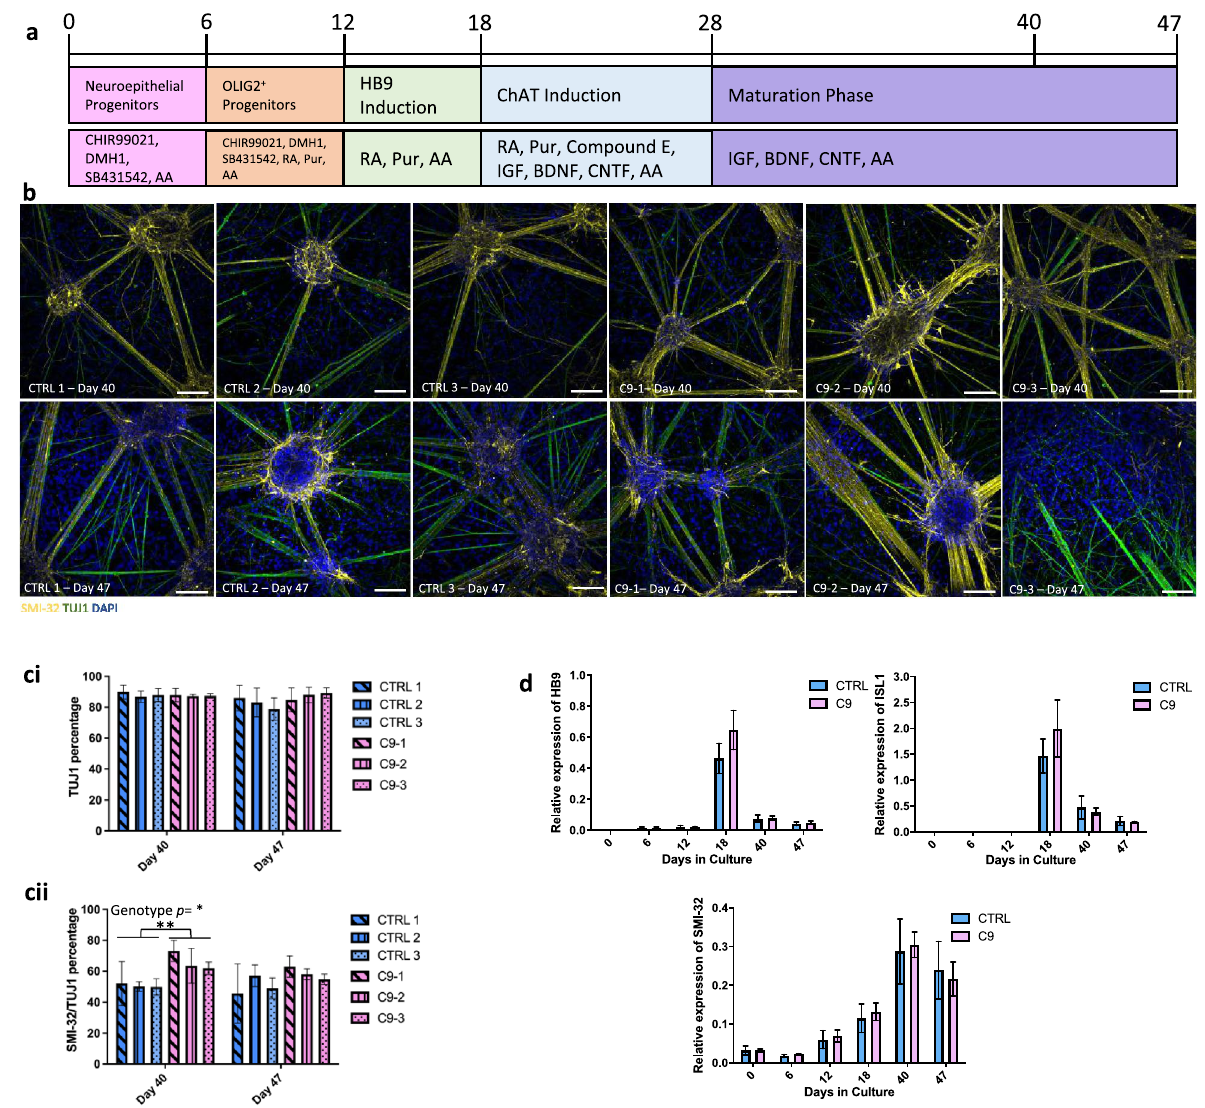
Figure 1. Characterization of C9ORF72 MNs and CTRL MNs. ( a ) Diagram of the MN protocol adapted from Du et al. 20 . ( b ) iPSC-derived MNs immunostained for SMI-32 and TUJ1. Scale bars = 100 µm. ( c ) Flow cytometry of cells stained with TUJ1 and SMI-32 to verify MN counts (mean ± SEM), analysed using FlowJo v10.4 Software (BD Life Sciences). Two-way RM ANOVA: Genotype p = 0.0233, Time p = ns, Interaction p = ns with Sidak’s multiple comparisons, ** p < 0.01, N = 3 lines, 3 differentiations ( d ) RT-qPCRs for HB9 , ISL1 and SMI-32 (mean ± SEM). Two-way RM ANOVA: Genotype p = ns, Time p = < 0.0001, Interaction p = ns, N = 3 lines, 2